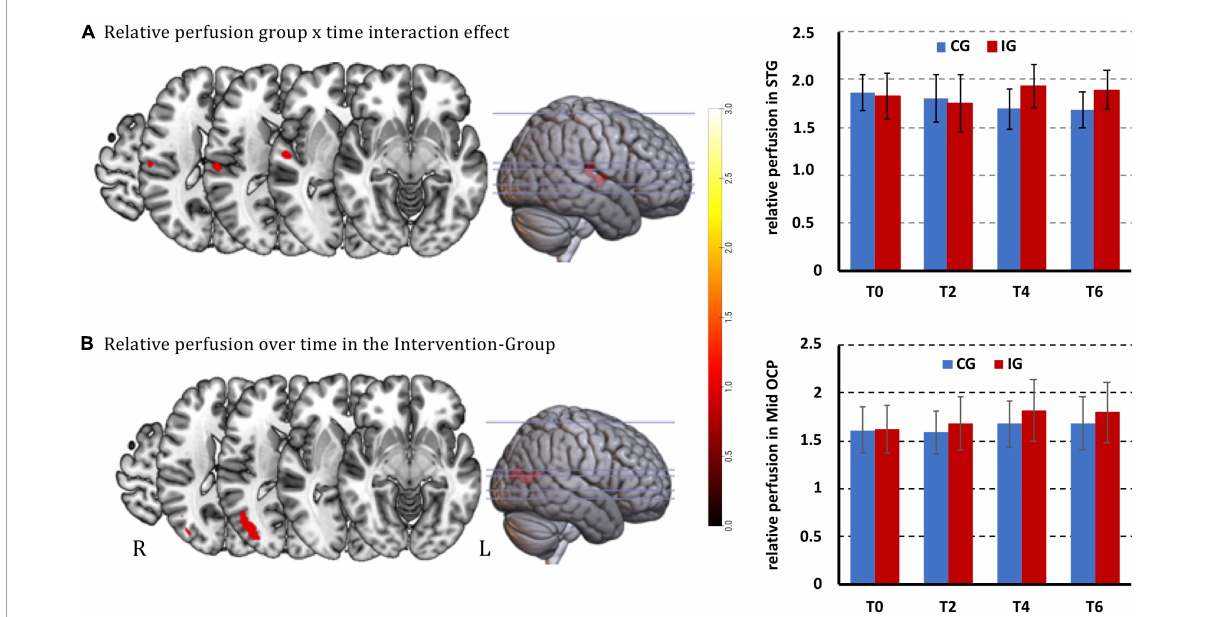
FIGURE3 Significant relative perfusion changes [ p < 0.001 (uncorrected), cluster level corrected at alpha = 0.05 with cluster size > 41 voxel for cluster-wise FWE]. (A) Increased group × time interaction effect in the right superior temporal gyrus and bar plots of beta values with standard deviations; (B) increased relative perfusion over time in the IG in the right middle occipital region. Clusters are overlaid on the structural MNI template of the brain and bar plots of beta values with standard deviations. The color bar from dark red to light yellow indicates the increasing relative GM CBF